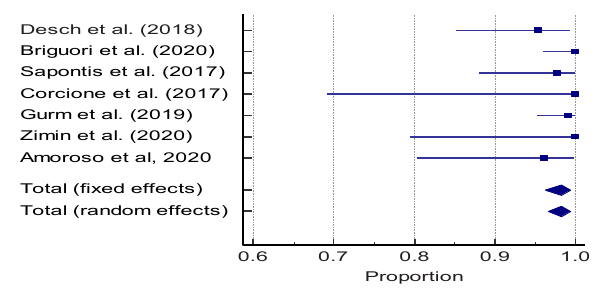
FIGURE 5 | Meta-analysis: Forest plot of image quality in the DyeVert group (Proportion of cases with adequate image quality per physician assessment).